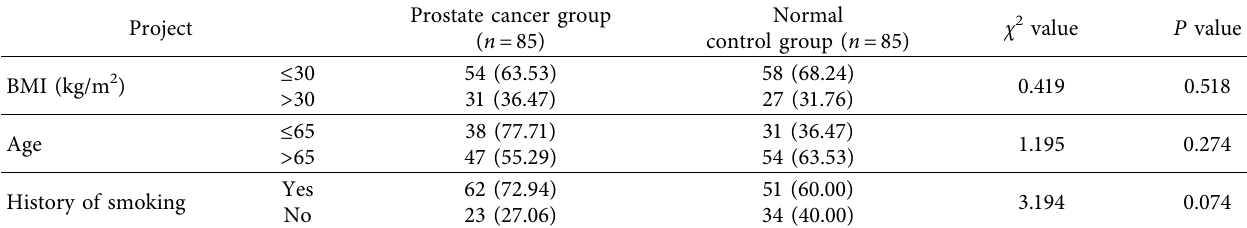
Table 2: Baseline data for subjects in the study ( n , %).